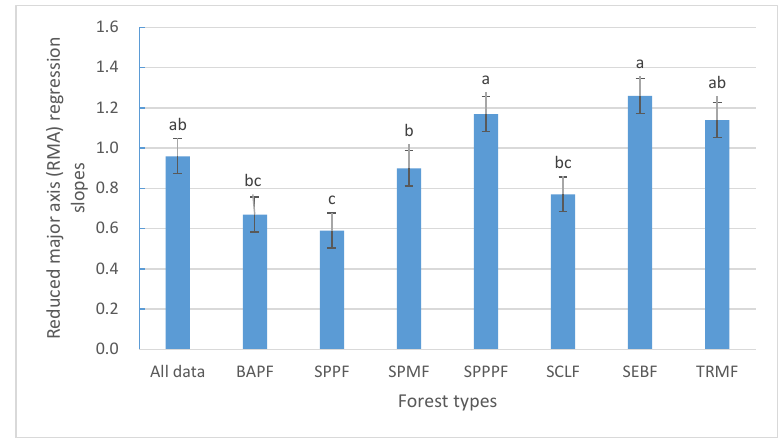
Figure 5. Reduced major axis (RMA) regression slopes of the relationships between forest root biomass per ha (RB, Mg/ha) and aboveground biomass per ha (AB, Mg/ha) for different forest types in southwest China. Lowercase letters represent 95% significant differences. BAPF: boreal/alpine Picea abies forest, SPPF: subtropical montane Pinus yunnanensis and P. khasya forest, SPMF: subtropical Pinus massoniana forest, SPPPF: subtropical montane Pinus armandii , P. taiwanensis and P. densada forest, TRMF: tropical rainforest and monsoon